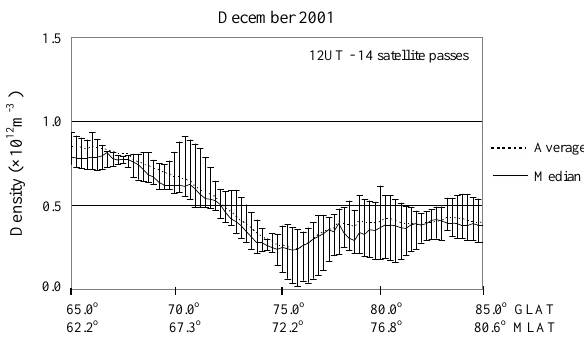
Fig. 2. Average and median electron densities at the F-region peak from the tomography images under quiet geomagnetic conditions between 11:30 UT and 12:30 UT in December 2001. The uncer- tainty bars indicate the inter-quartile ranges.